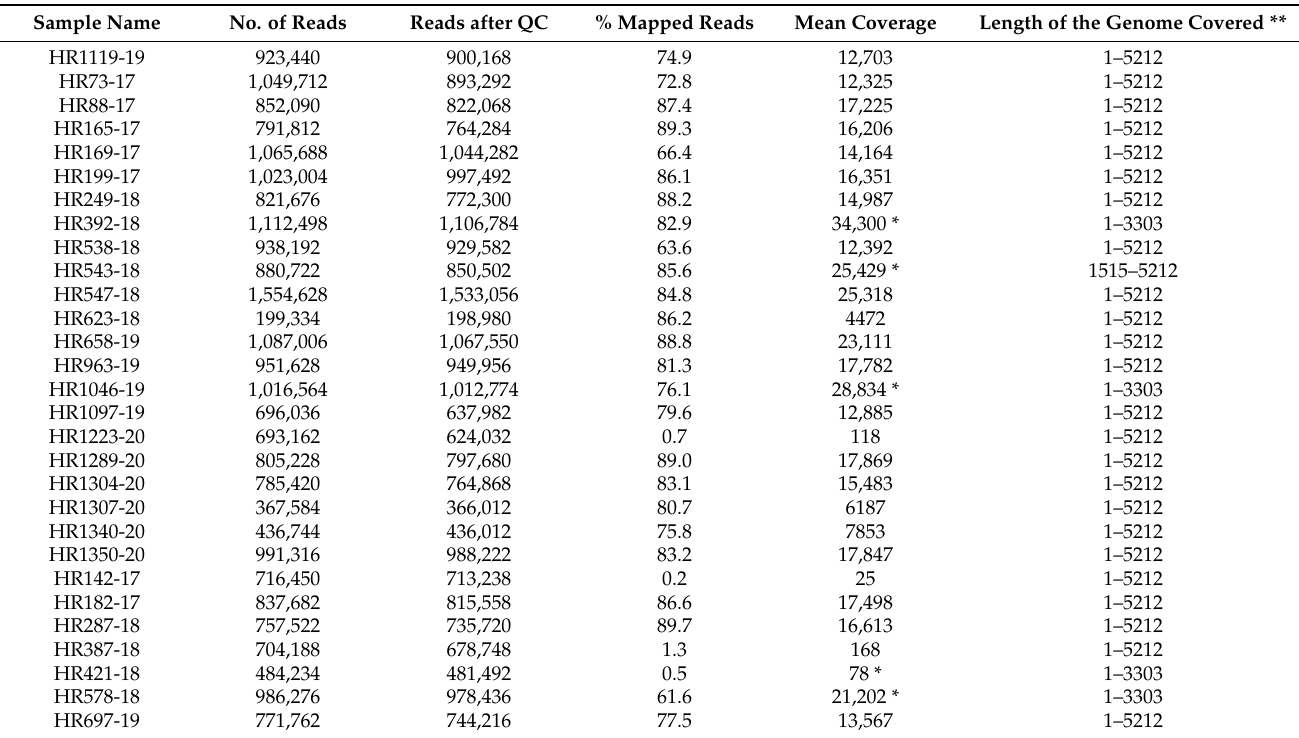
Table 1. Summary of sequencing